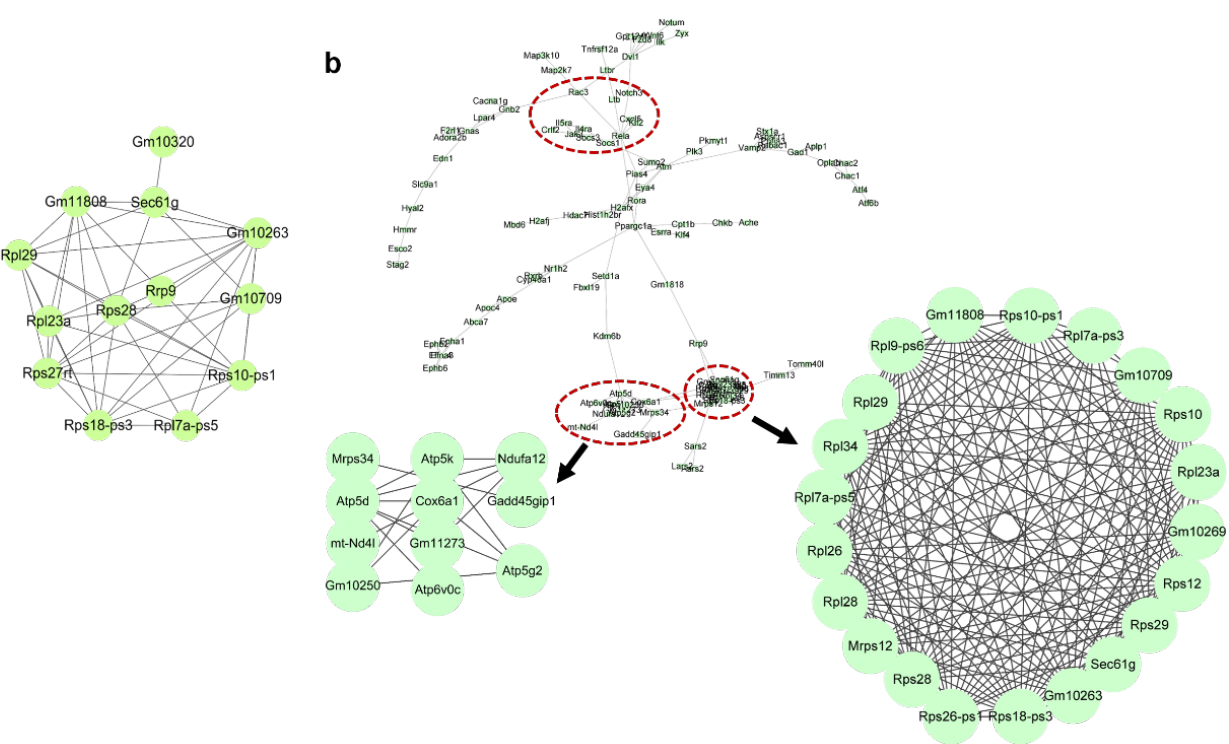
Figure 3. Protein–protein interaction (PPI) network of differentially expressed gene dependence on intervention group: ( a ) low-dosage intervention and ( b ) high-dosage intervention group. The PPI network was produced using STRING and Cytoscape software. Key nodes to modulate relative pathways were labeled using circles with different colors.